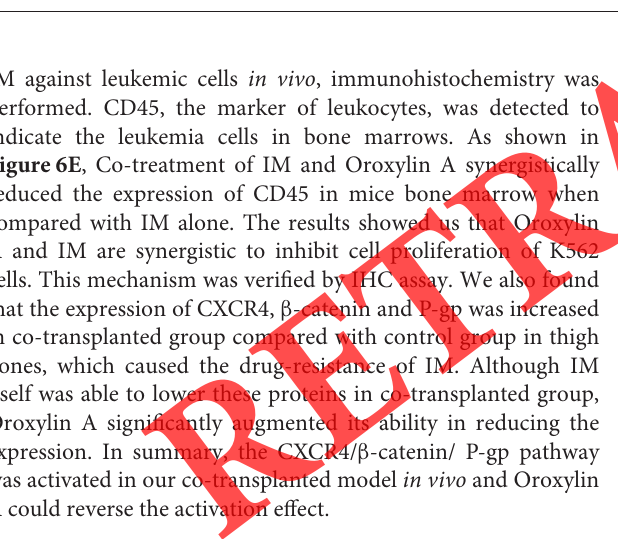
FIGURE 2 | BM microenvironment stimulated CXCL12 secretion and activates CXCR4 in CML cells. K562 and KU812 cells were cultured with or without hBMSCs for 24h or 48h. (A) ELISA assay detection of CXCL12 secretion in CML cells co-cultured with BMSCs. (B) Western blot analysis of expression after cells co-cultured with BMSCs and Neutralizing CXCL12 (10 µ g/ml). (C) Analysis of proteins expression. (D) The expression of downstream protein of CXCR4 was analyzed by western blot analysis. (E) Analysis of proteins expression. (F) Immunofluorescence detection of the distribution of β -catenin in K562 cells. Data (A,C,E) were shown as Means ± SD for three independent experiments (* p < 0.05 and ** p <